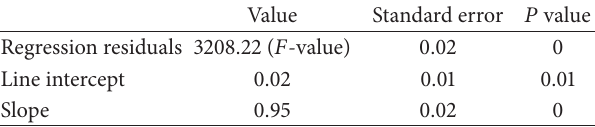
Table 3: Linear regression analysis results based on 45 ∘ line for